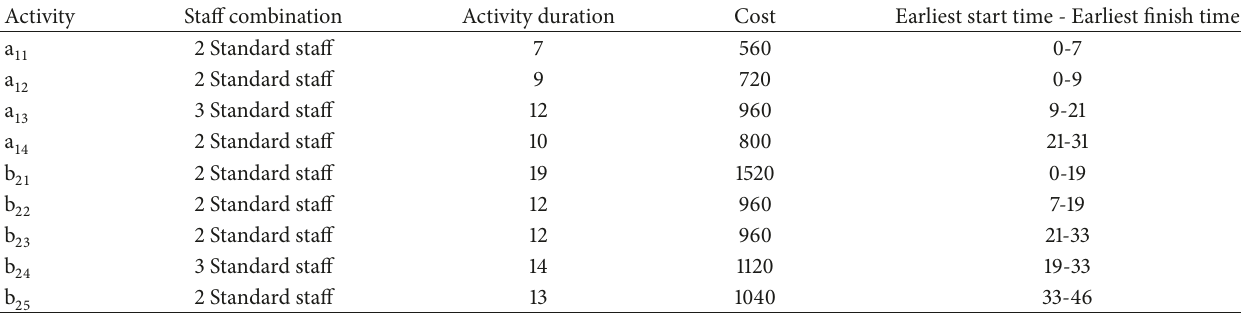
Table 8: The optimal scheduling scheme of traditional